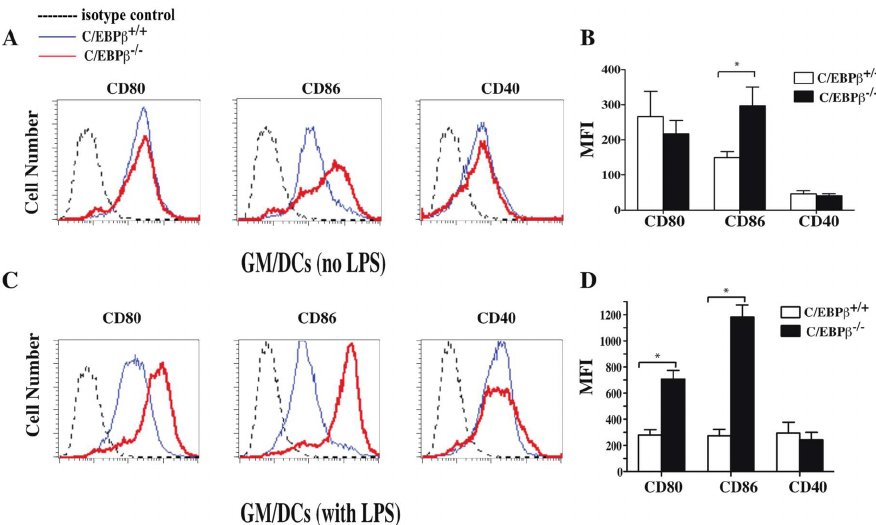
Figure 5. Effect of C/EBPβ deficiency on the maturation status of GM/DCs. Bone marrow-derived GM/DCs generated from C/EBPβ +/+ mice (Blue line) and C/EBPβ −/− mice (red line), were left unstimulated ( A ) or exposed to LPS (1 μg/mL for 48 h) ( C ) and were stained and analyzed for CD80, CD86, and CD40 expression on CD11c + cells using flow cytometry. Dashed thin lines represent labeling with isotype control antibodies. ( B and D ) Expression levels of CD80, CD86, and CD40 cell surface markers on unstimulated ( B ) and LPS exposed ( D ) GM/DCs are illustrated as mean fluorescence intensities (MFIs). The results are representative of three independent experiments. * p < 0.05, nonparametric unpaired Mann—Whitney test.